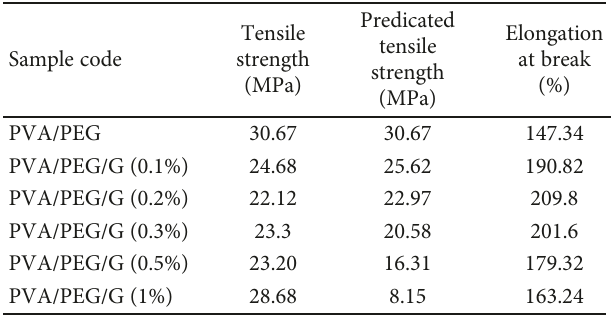
Table 5: Mechanical properties of PVA/PEG blend and its nanocomposites at di ff erent graphene